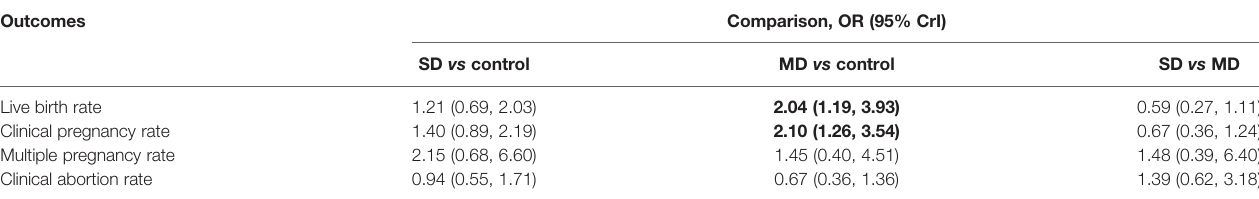
TABLE 2 | Results of network meta-analysis.